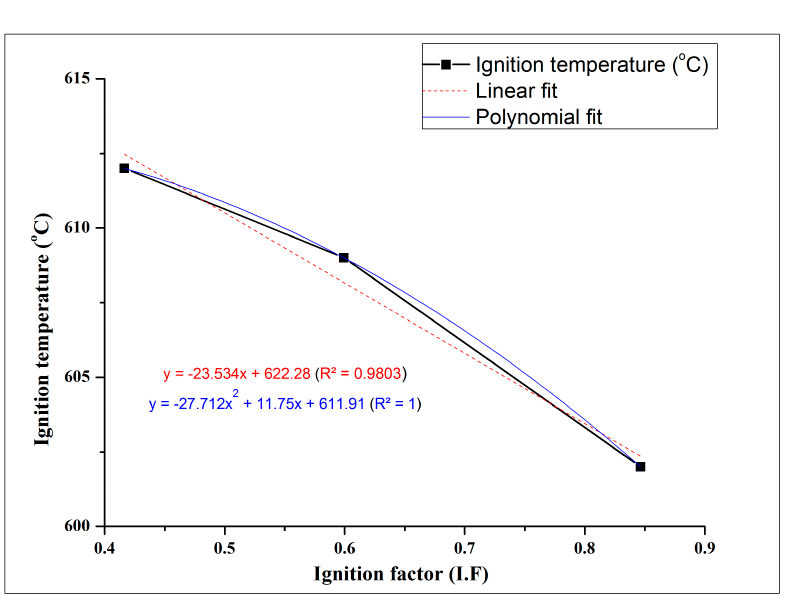
Figure 2. Ignition temperature versus ignition factor (IF) of the synthesized Mg/GMB syntactic foams.